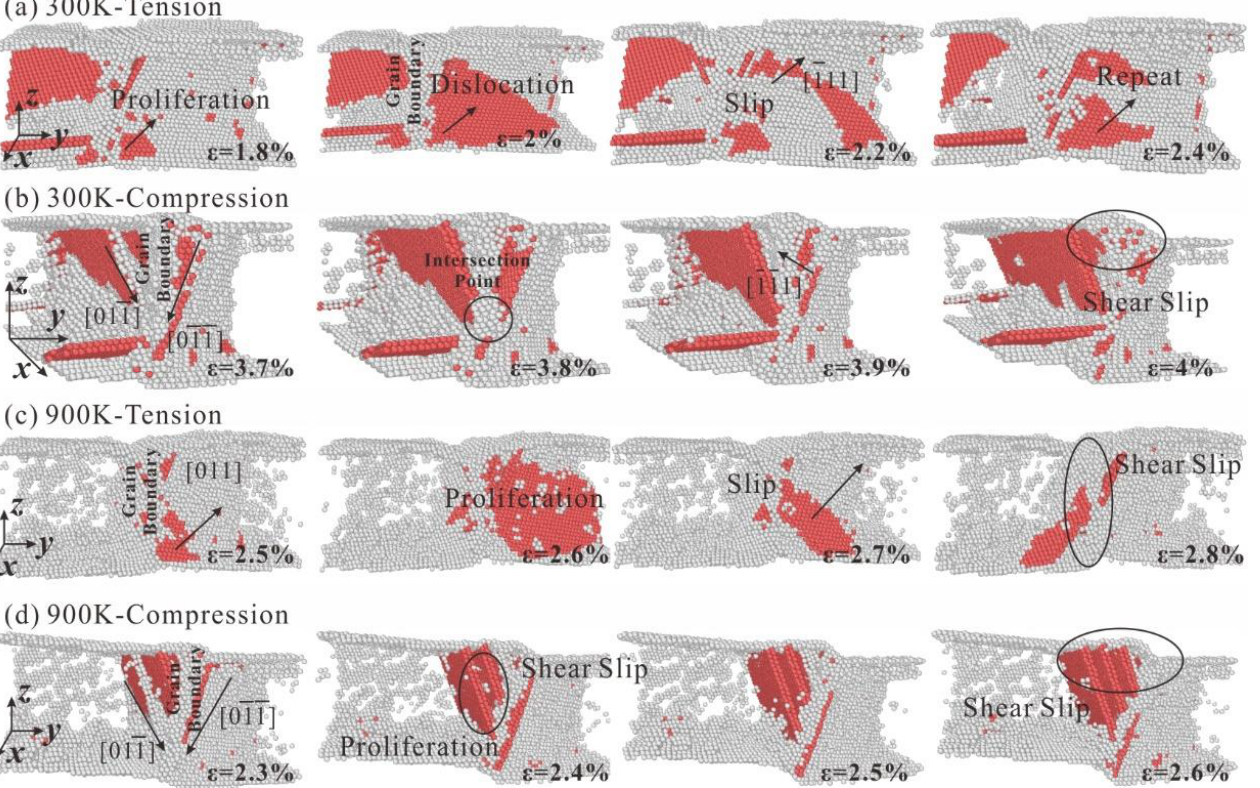
Figure 9. Microstructural evolution of polycrystalline HEA with grain number of 5, ( a ) Tensile load at 300 K, ( b ) Compressive load at 300 K, ( c ) Tensile load at 900 K, and ( d ) Compressive load at 900 K. The internal microstructure evolution diagram of polycrystalline HEA with a grain count of 15 when it is stretched and compressed at 300 K and 900 K can be seen in Figure 10.